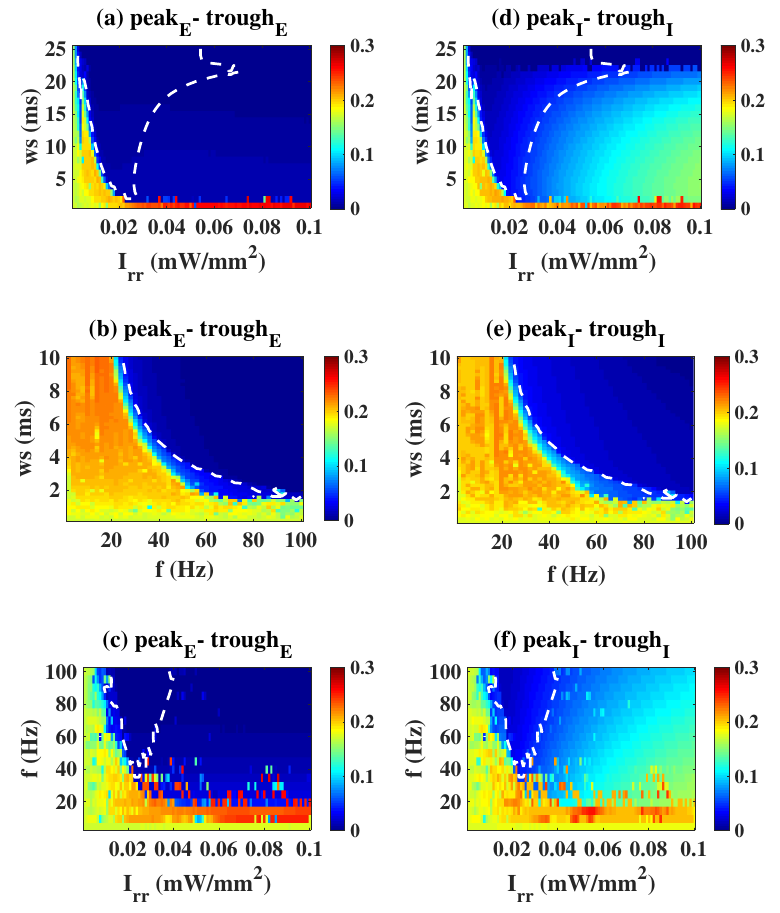
Figure 3. Evolutions of the observed indicators on the two-stimulus parameter plane. Areas enclosed by the white dashed line are the effective parameter area (peak, trough, peak-trough of E and I are all smaller than 0.05). ( a , d ): f = 40 Hz, ( b , e ): I rr = 0.015 mW/mm 2 , ( c , f ): ws = 2